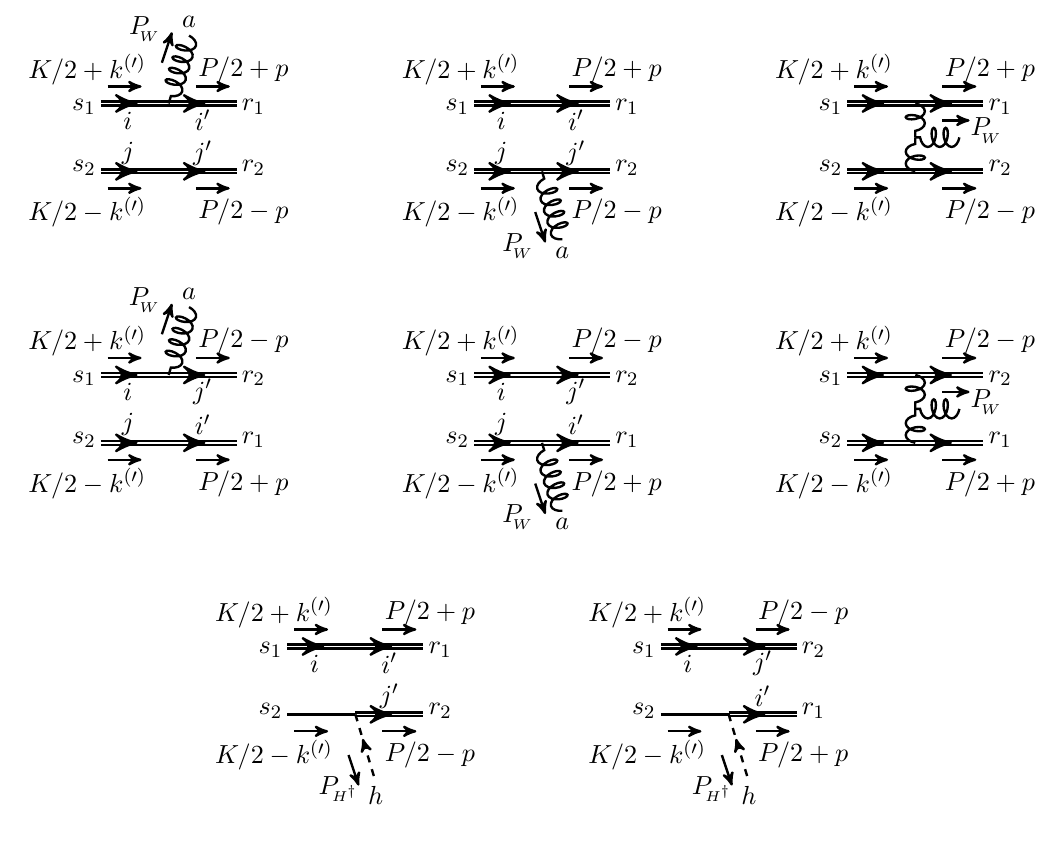
Figure 7 . Same as figure 5, for the formation of DD bound states. Top two rows: DD → B ( DD ) + W . Bottom row: DS → B ( DD ) + H †